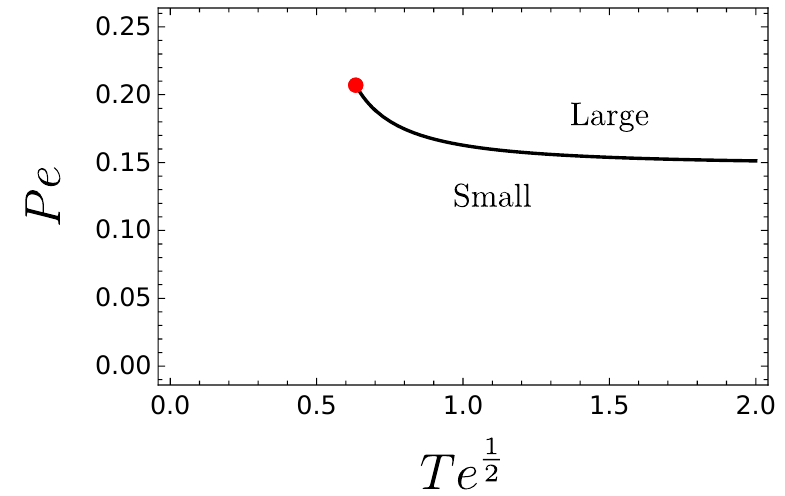
Figure 3 . Phase diagram . The phase diagrams for (cid:12)ve dimensional charged black branes is displayed. This plot was constructed for the particular example of (cid:12) 3 = 4 and (cid:12) 4 = (cid:0) 9, though these values are not special and any combination in the green region of (cid:12)gure 2 would produce a qualitatively similar plot. Here the dimensionful quantities have been rescaled in terms of the electric charge parameter e , which has subsequently been set to